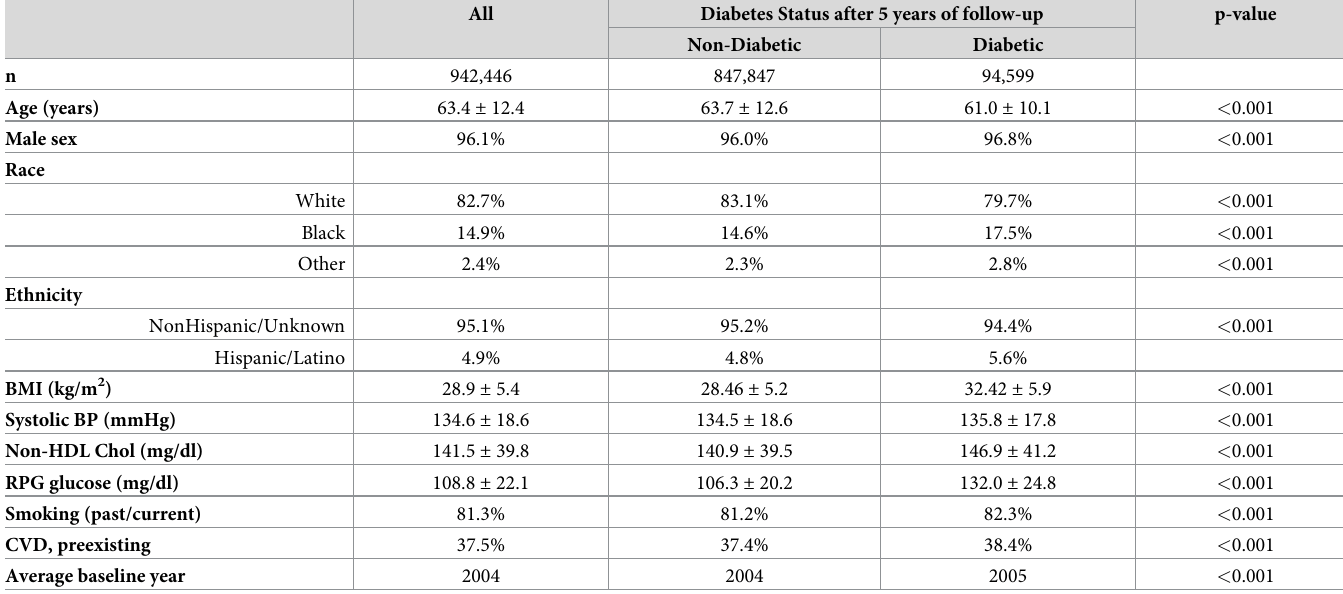
Table 1. Patient characteristics at